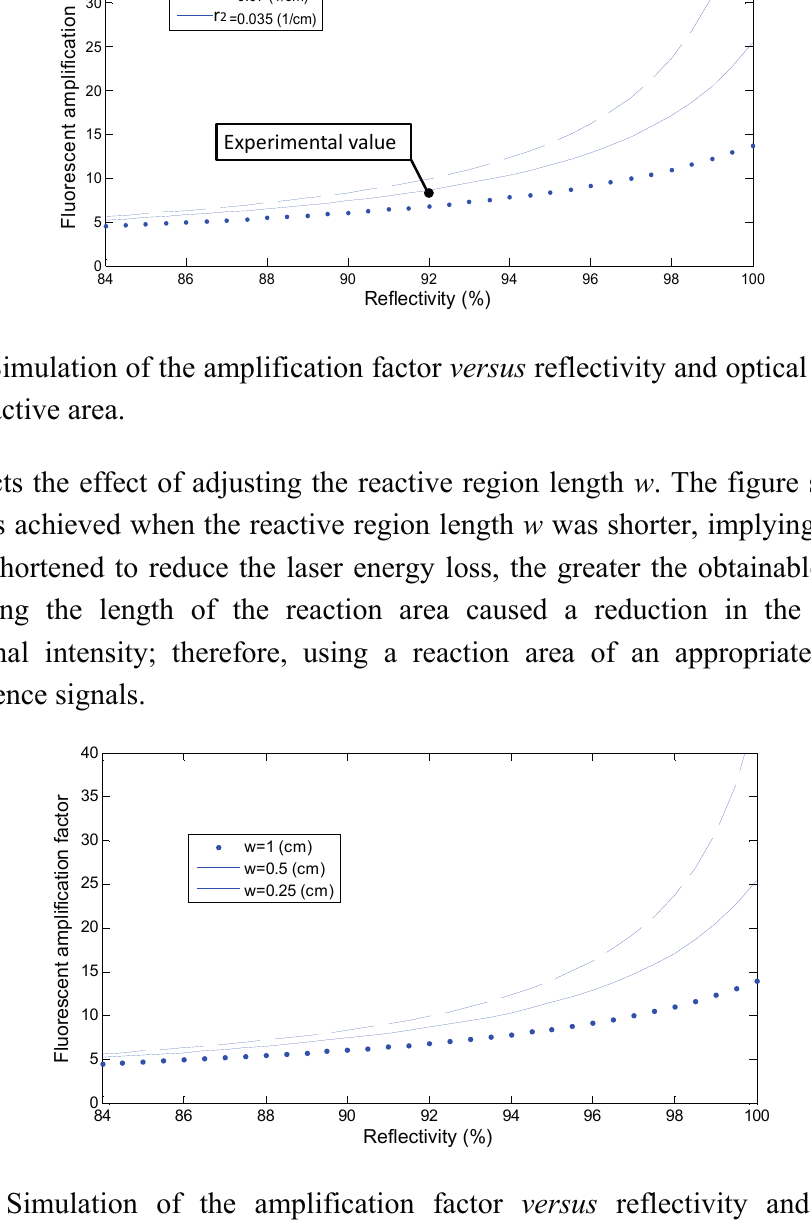
Figure 7. Simulation of the amplification factor versus reflectivity and lengths w , r 2 = 0.07 (1/cm) at the reactive